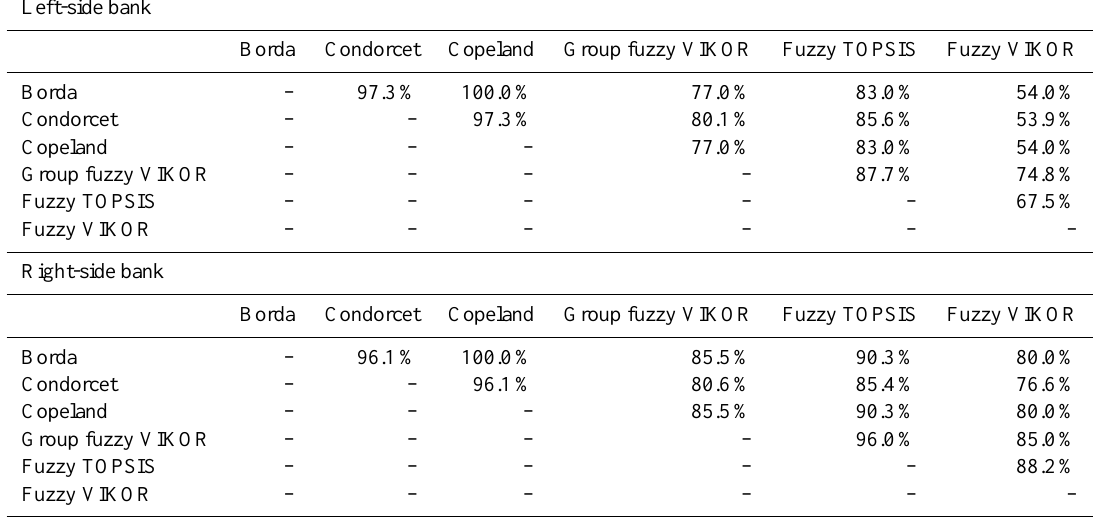
Table 5. Determined Spearman’s correlation